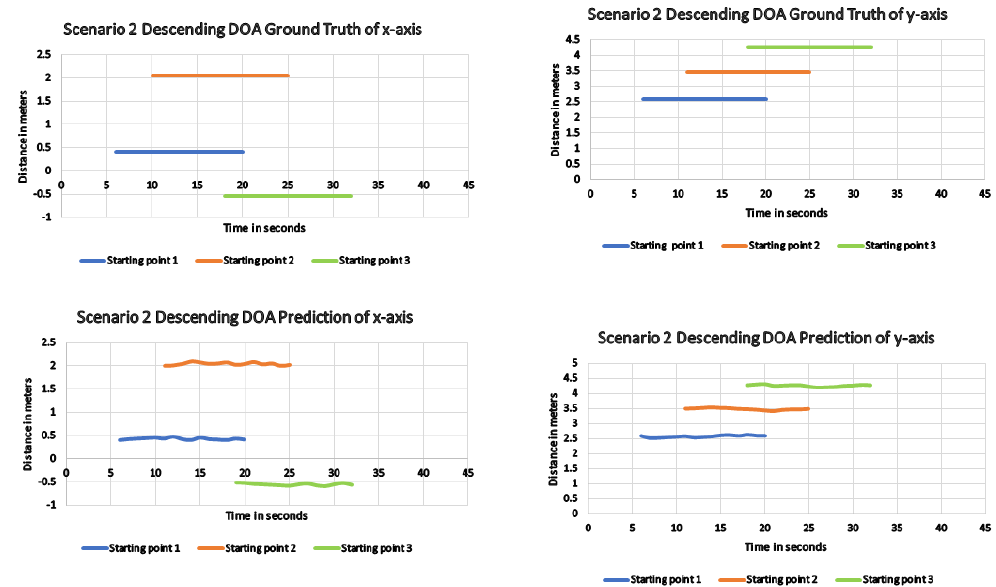
Figure 13. DOA result for the proposed method showing the difference in the actual and predicted x, y coordinates of scenario 2 descending direction.